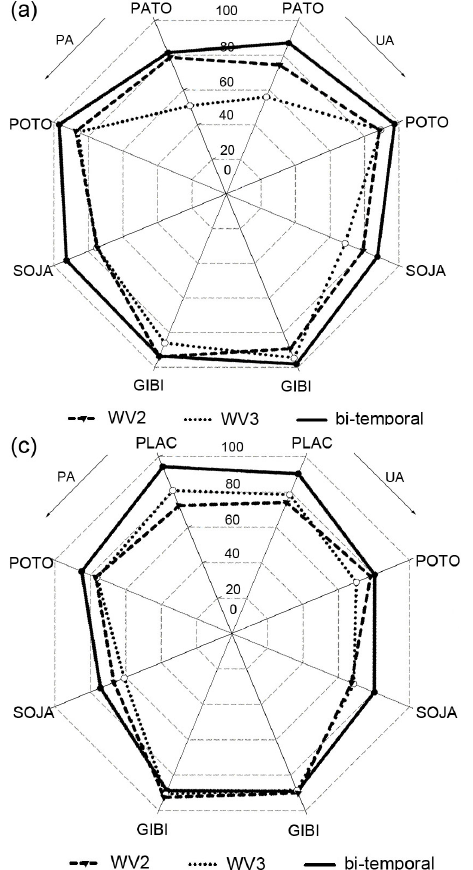
Figure 5. Radar charts of three classification schemes with SVM and RF methods in two study areas. ( a ) PAs and UAs using SVM at CNU; ( b ) PAs and UAs using RF at CNU; ( c ) PAs and UAs using SVM at BNU; ( d ) PAs and UAs using RF at BNU. PA: producer accuracy; UA: user accuracy.